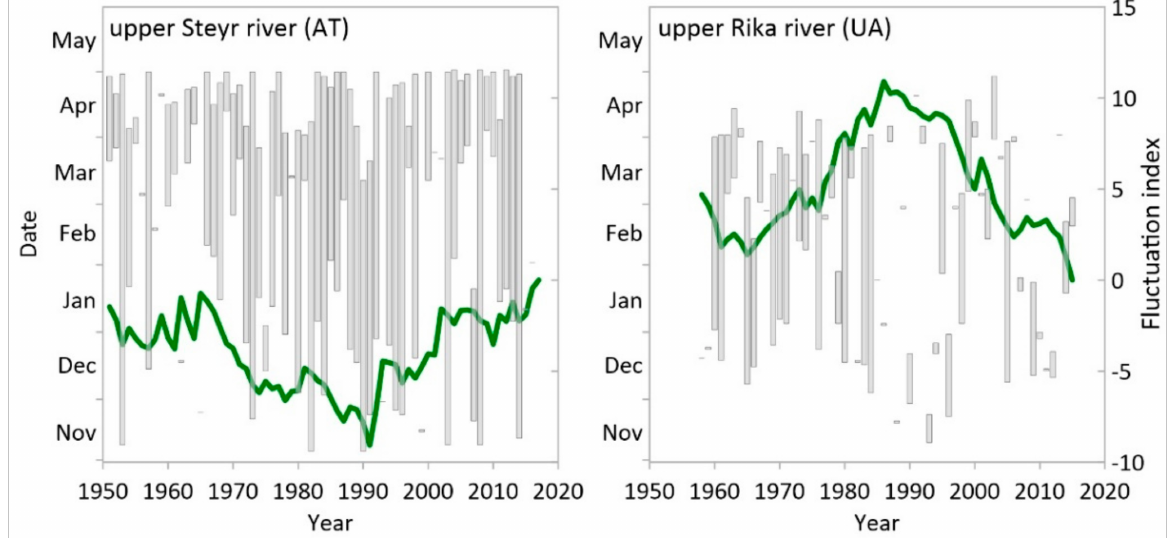
Figure 5. Seasonality of winter floods (grey lines). The grey band represents the variability of flood occurrence between the catchments from the same region. The green line indicates fluctuation index in the Steyr River − Klaus an der Pyhrnbahn ( left ) and Rika River − Mizhhiria village ( right )